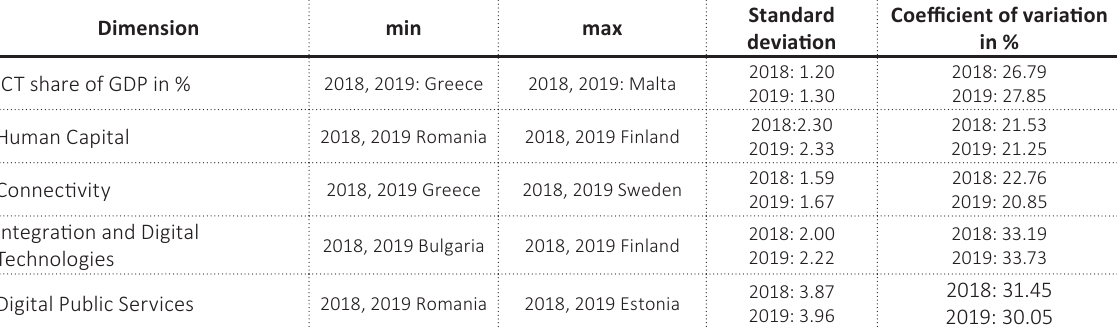
Table 1. Characteristics of inputs and output